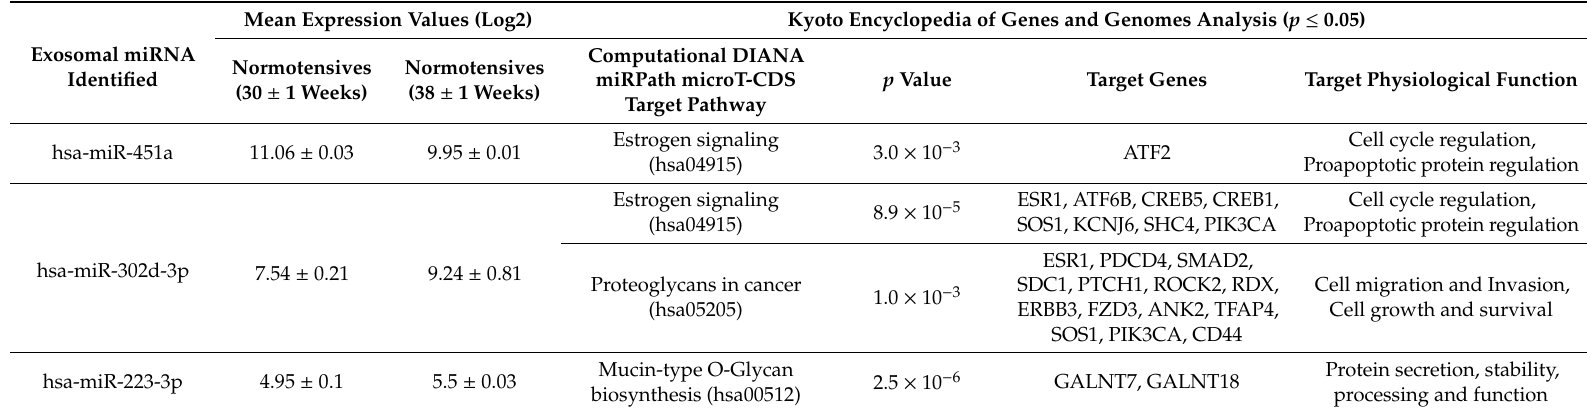
Table2. ComputationalMergingandMeta-AnalyticalPathwayAnalysis(DIANAmirPATH)ofDi ff